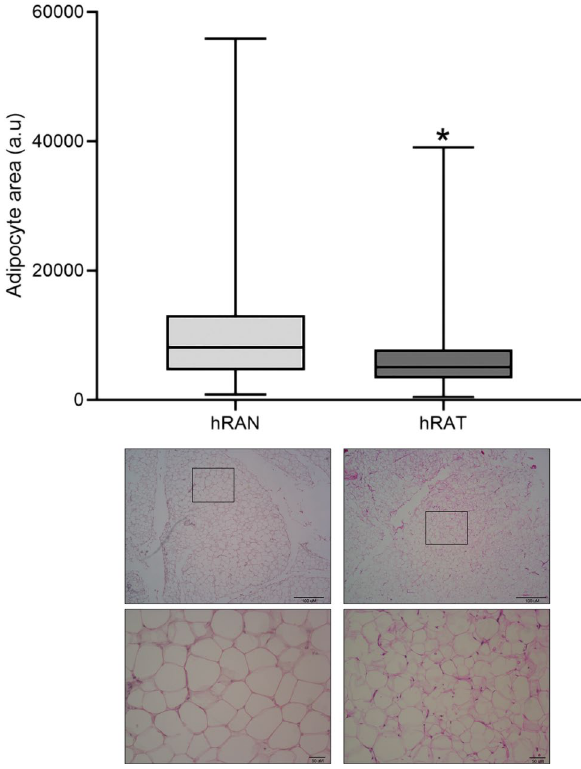
Figure 1. Microscopic evaluation of different renal adipose tissues. Slides from adipose tissue samples from hRAN; and tissue samples of tumor kidney attached to the tumor of hRAT. Adipose tissue fragments were cut in paraffin, stained with H&E, and observed under light microscope. Adipocyte size was quantified with Image J software (NIH). The graphic shows the median ± SEM of two independent experiments. * p < 0.05 hRAT attached to the tumor versus hRAN. Magnification: 10X and 40X. Arbitrary units (a.u) represent pixel quantification.